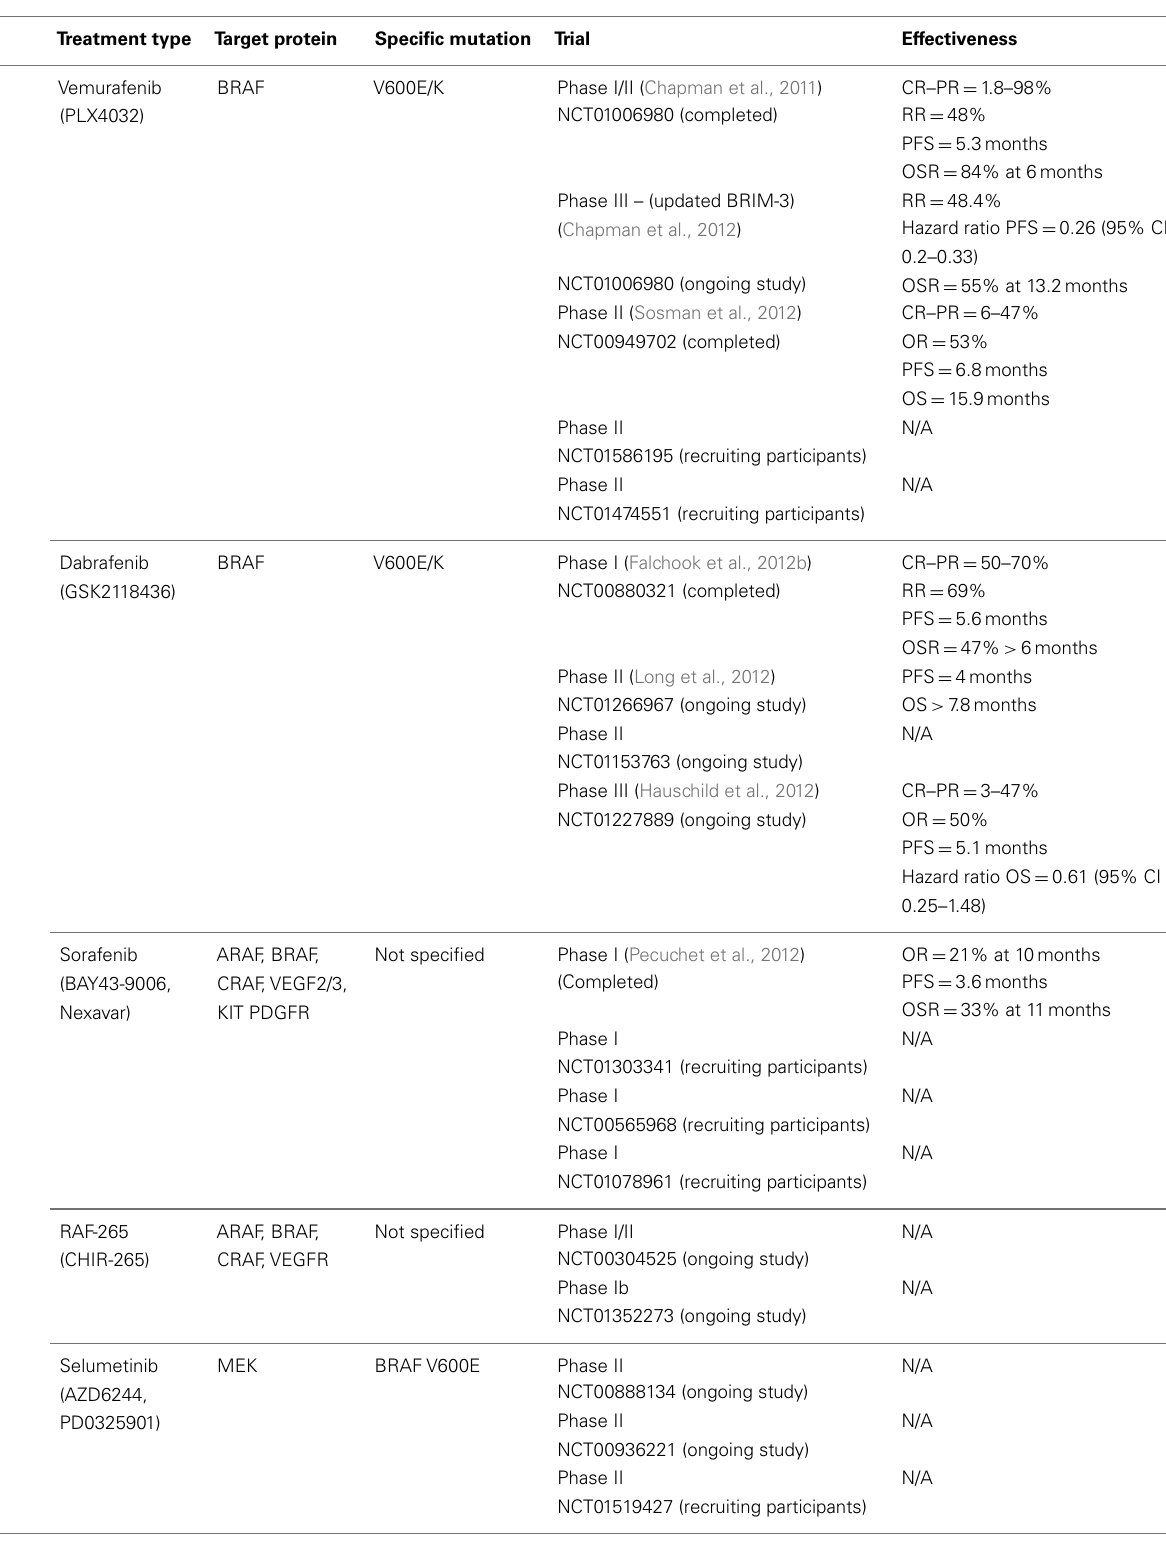
Table 1 |Anti-cancer inhibitors undergoing testing for treatment of cutaneous